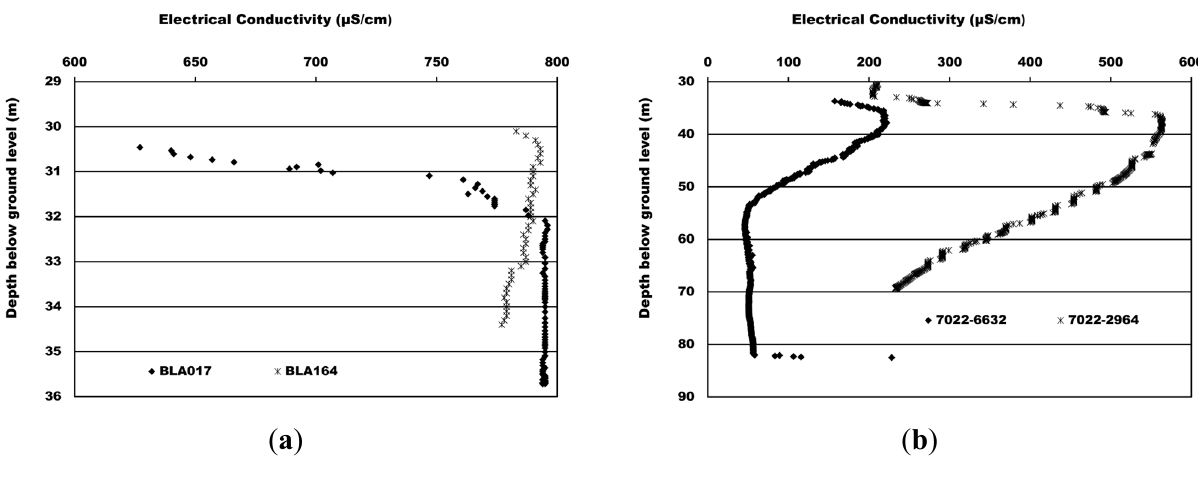
Figure 14. Salinity profiles ( a ) Monitoring wells ( b ) Drainage